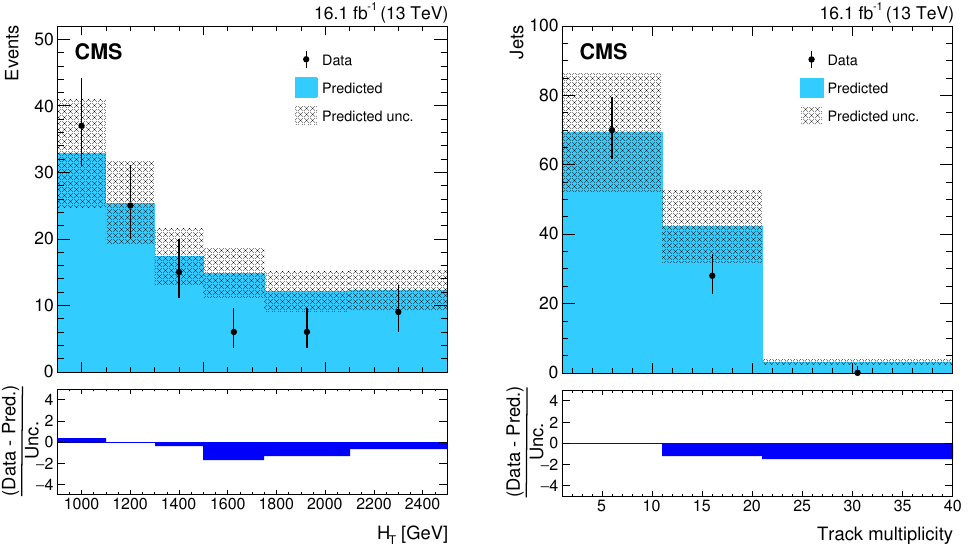
Figure 8 . The H T (left) and number of associated tracks (right) distributions of the observed data events (black points) and the predicted background estimation (blue) for selection set 9 (SM QCD-enhanced), requiring at least one jet tagged by loose emerging jet criteria and large p miss The bottom panel shows the di(cid:11)erence between observed data and predicted background, divided by the sum in quadrature of the statistical uncertainty in data and the predicted uncertainties from misidenti(cid:12)cation probability